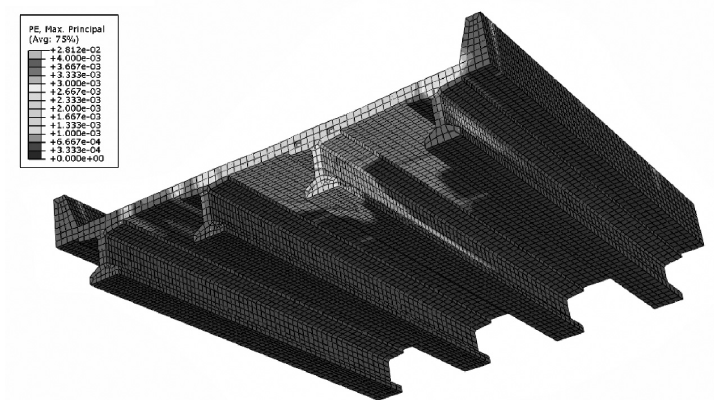
Fig. 24. Maximum principal plastic strain, blast above, centered on a girder. Bottom view.